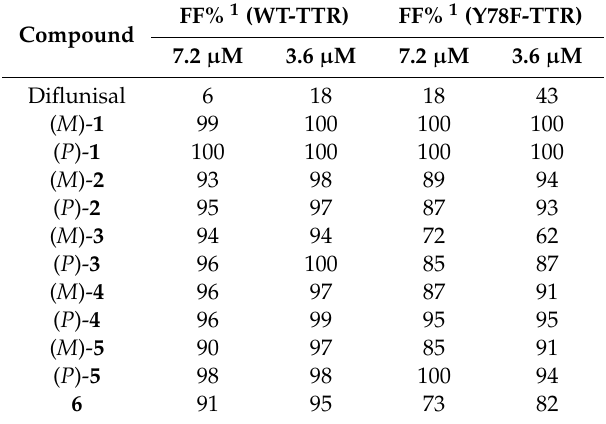
Table 1. Inhibition of WT- and Y78F-TTR amyloid fibril formation under acidic denaturation condition in the presence of diflunisal, pure enantiomers of derivatives 1 – 5 , and achiral 6 .